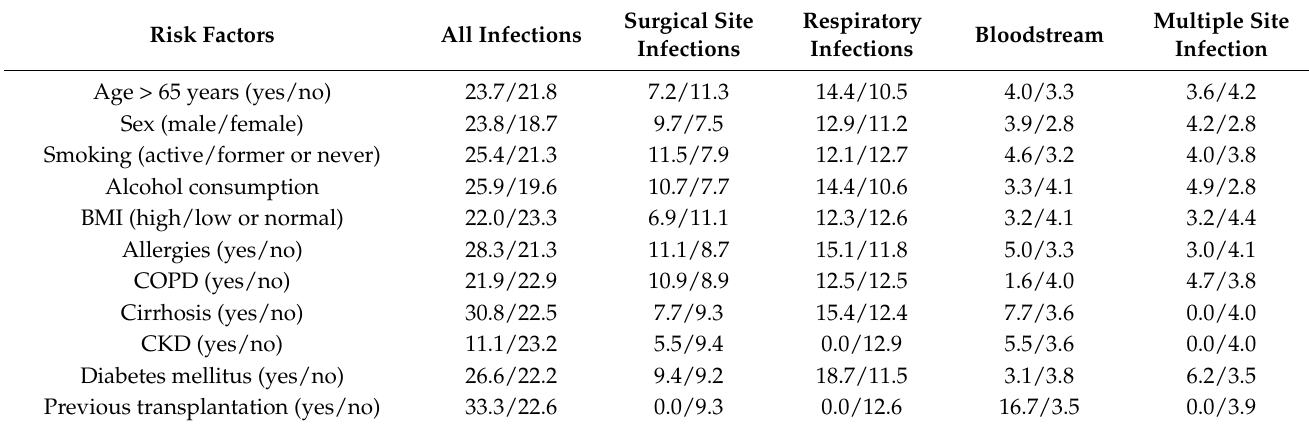
Table 4. Percentage of post-operative infection for each risk factor in different